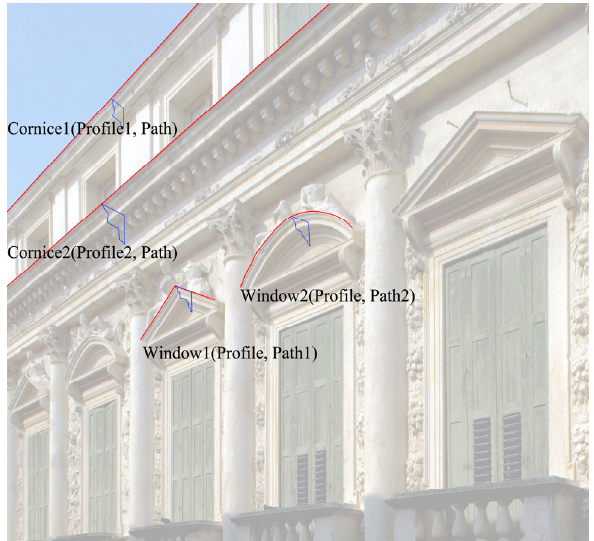
Figure 4. Two groups of components sharing the same path and